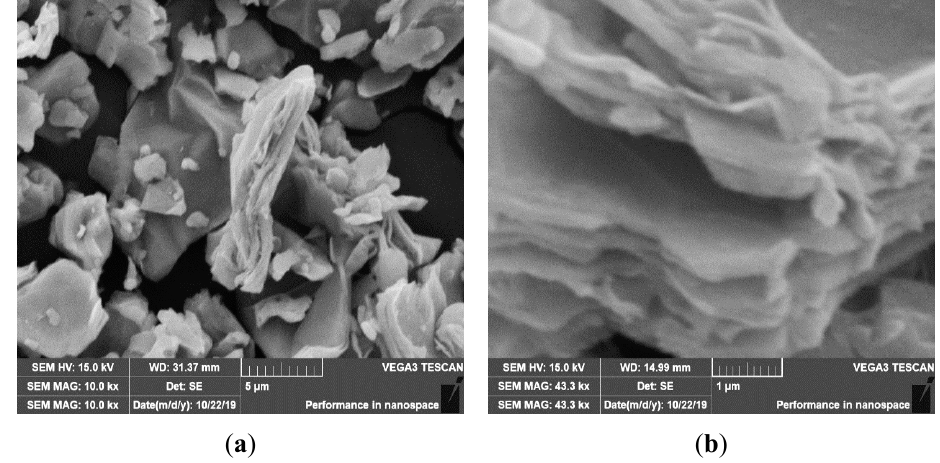
Figure 6. SEM micrographs of as synthesized Ti 3 C 2 (MXene) ( a ) at 5 µm magnification ( b ) at 1 µm